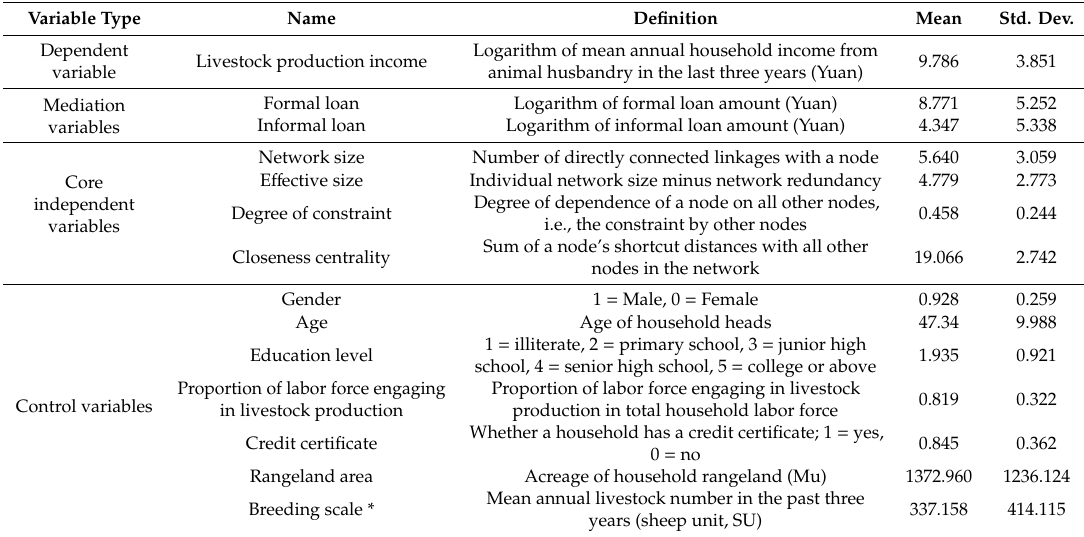
Table 3. Variable definitions and basic